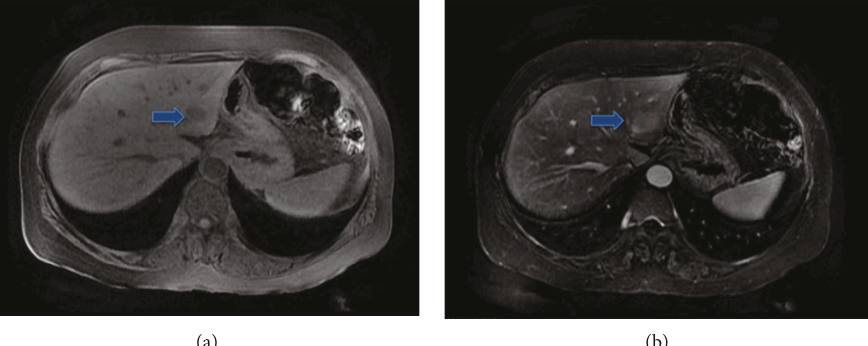
Figure 2: Magnetic resonance imaging (MRI) axial cuts showing the left lateral section liver lesion being hypointense on T1-weighted images in (a, blue arrow) and slightly hyperintense on T2-weighted MRI images in (b, blue arrow).